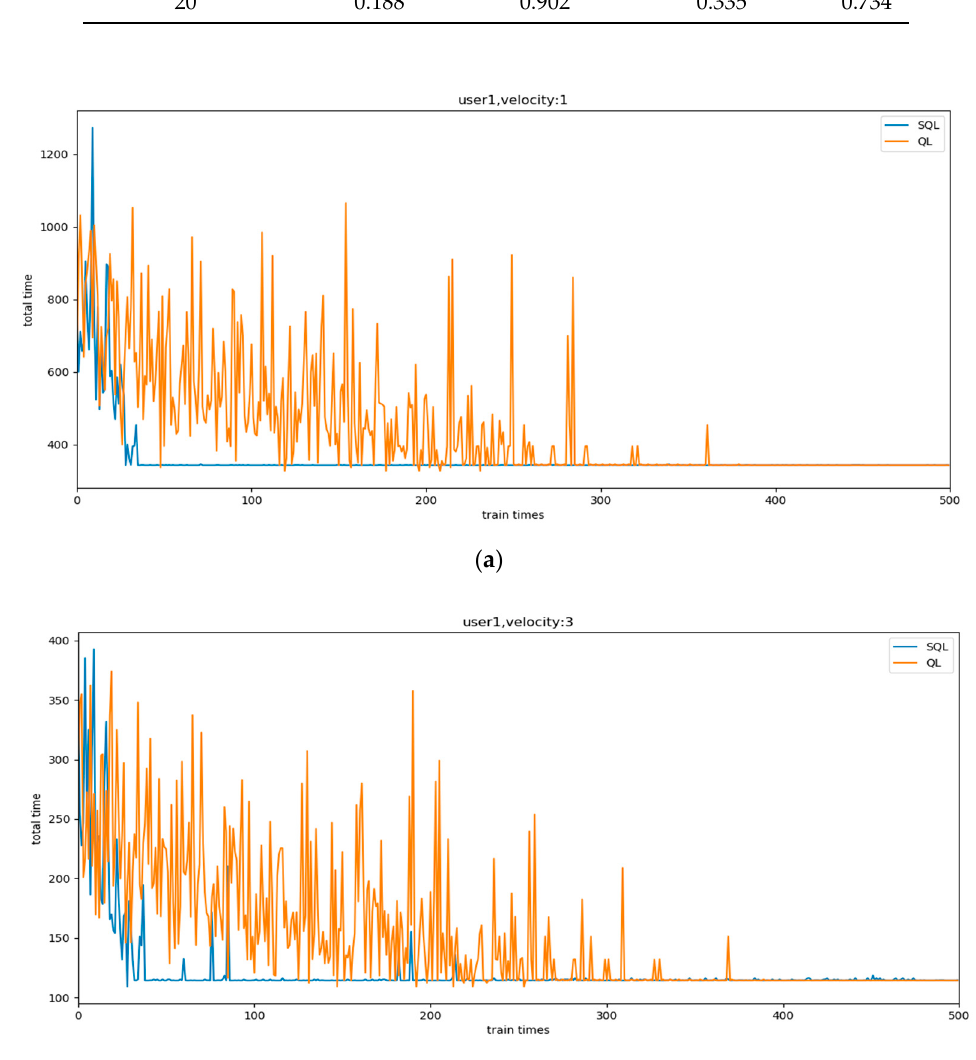
Table 2. The sparse degree of Q value.